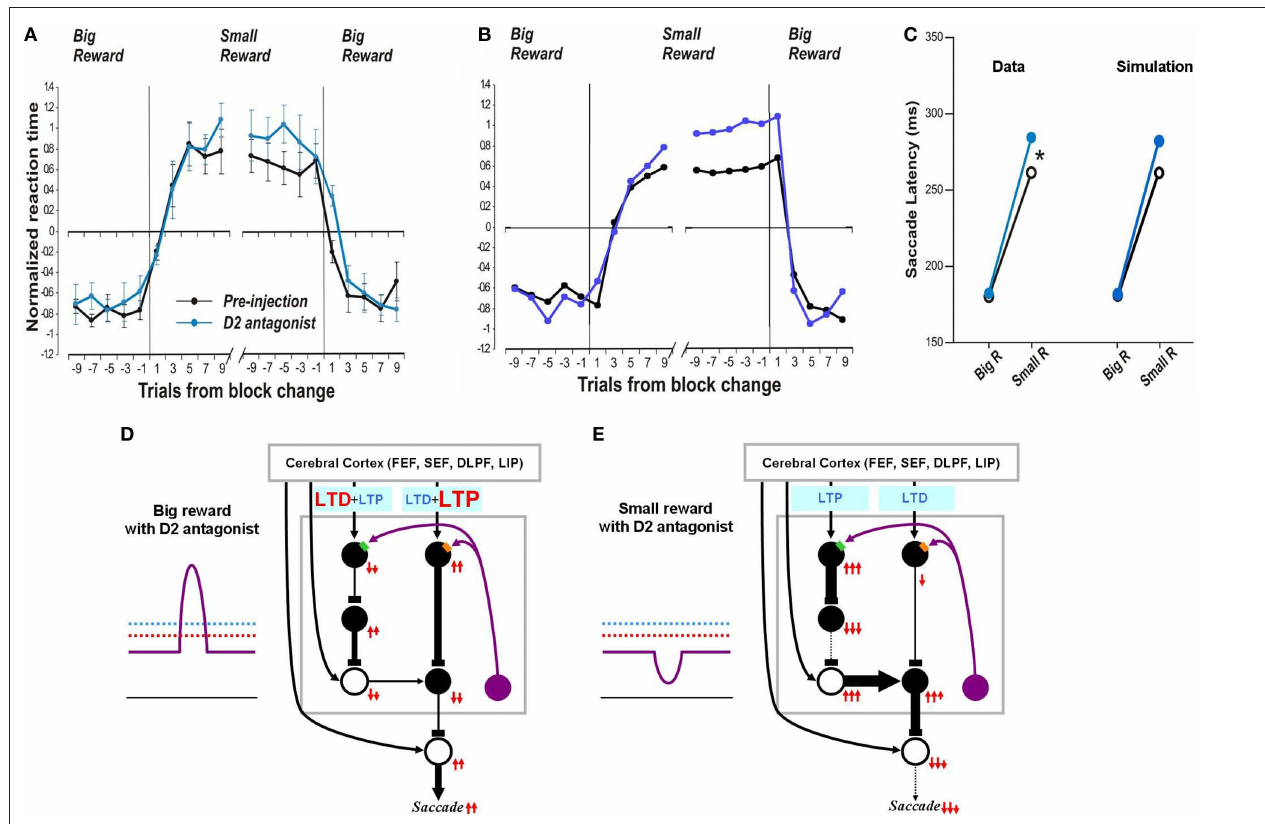
big-reward trials. The phasic increase in the DA level exceeds both the D1 and D2 thresholds, although the D2 antagonist elevates the D2 threshold, and therefore the saccade latency remains largely unchanged. (e) Hypothesized mechanism of the effect of D2 antagonist in small-reward trials. The elevated D2 threshold eliminates the DA-dependent LTD in the indirect pathway MSNs and therefore potentiates the SNr-induced inhibition of the SC, leading to a longer latency